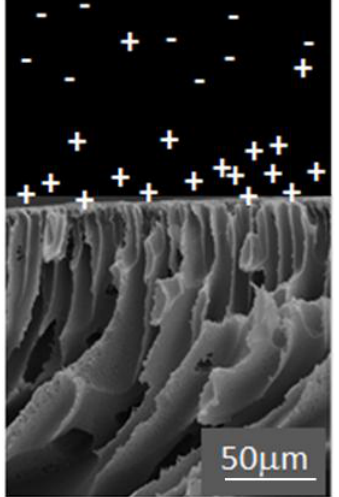
Figure 5. Charge concentration effect—visualization with SEM image of membrane with GO-TiO 2 (1 wt %)/polyethersulfone (PES) porous support layer.